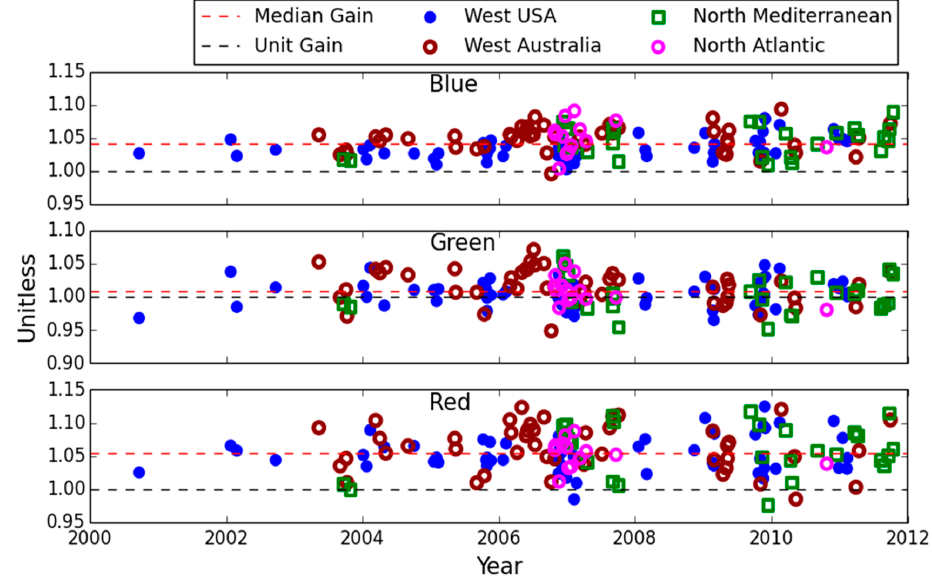
Figure 4. The vicarious gains for TM visible bands. Each data point corresponds to a TM-MODIS near-concurrent matchup, i.e., same-day overpasses, over various calibration sites. The temporally median gains and (one) standard deviation applied to TM data are provided in Table 2. Note that the gains are derived after vicariously calibrating NIR and SWIR-I bands.